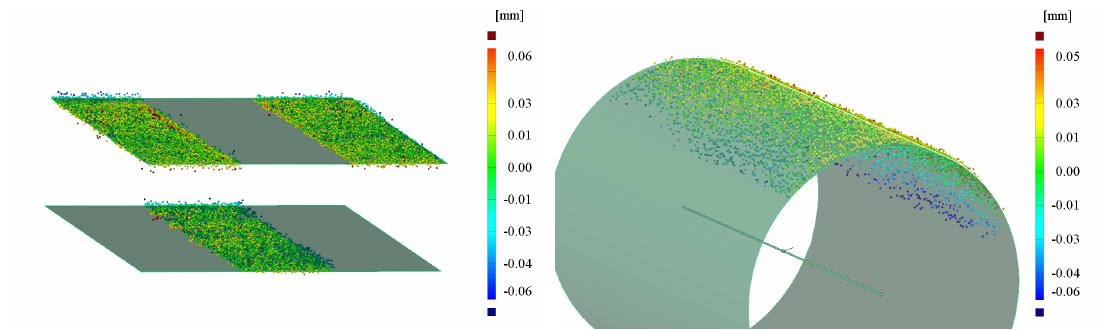
Figure 5. Distances of the sample measurements points to the nominal geometry of the gap (top left), the cylinder with radius 1mm.